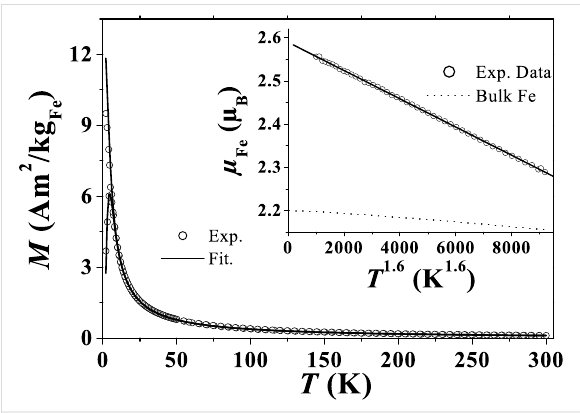
0.05 µ B , well above the bulk